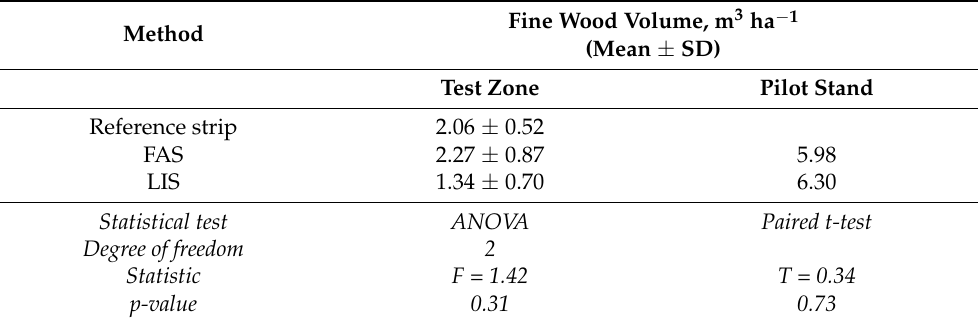
Table 1. Comparison of the VFWD volume (pieces < 4 cm) collected according to the fixed-area sampling (FAS), line-intersect sampling (LIS) and Reference strip applied in the Test Zone and in the Pilot Stand, and results of statistical tests.